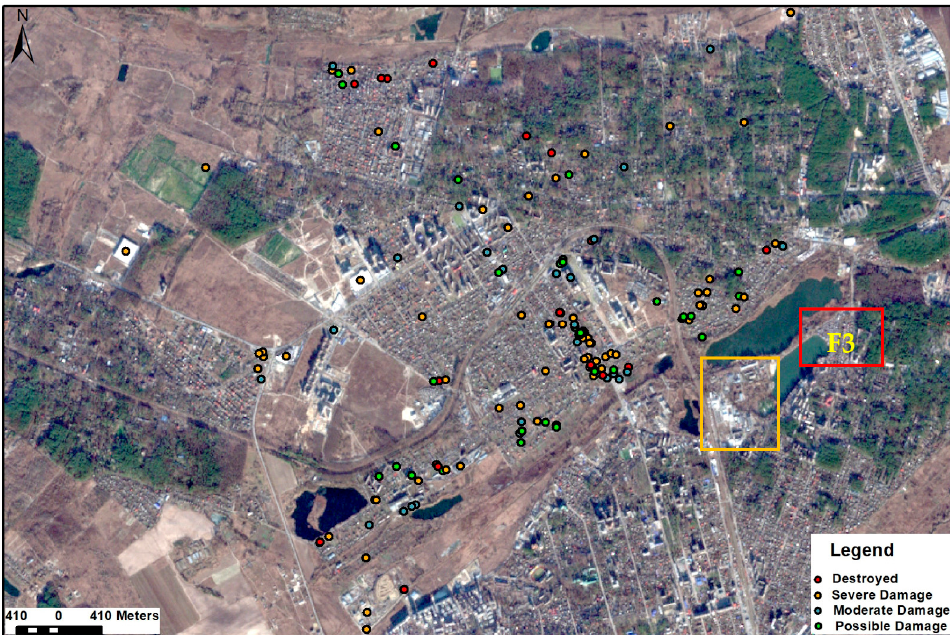
Figure 2. UNOSAT damage assessment map of Bucha city. The background image is from Sentinel-2 acquired on 2 January 2022. The red rectangular box denotes the area shown in Figure 3, and the orange rectangular box shows the AOI for threshold selection.